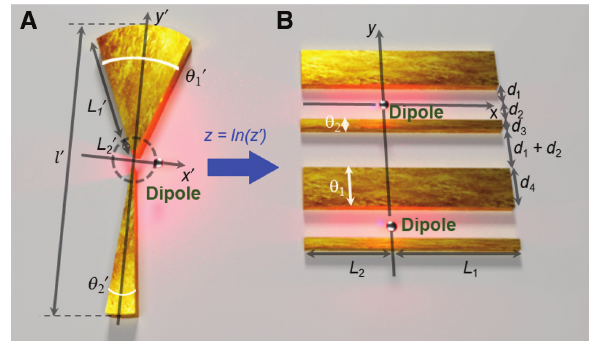
Figure 1: Transformed and original space for the nanoantennas under